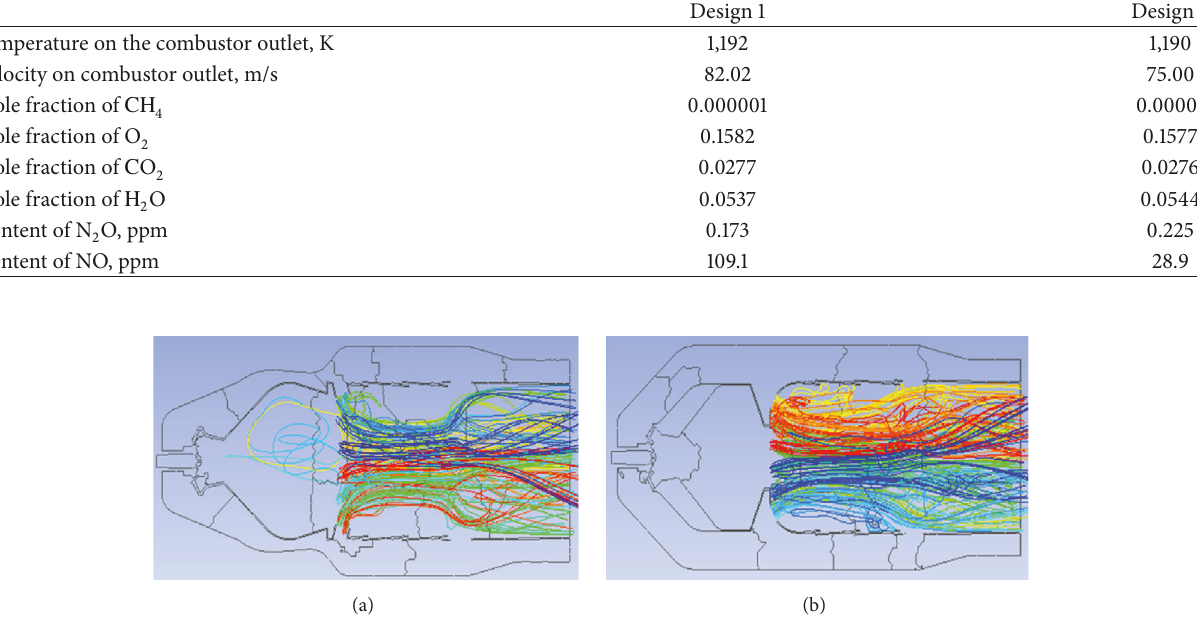
Figure 14: Lines of the air tracks of the quick mixing (Quick-Mix) zone: (a) modified design 1; (b) modified design 2.